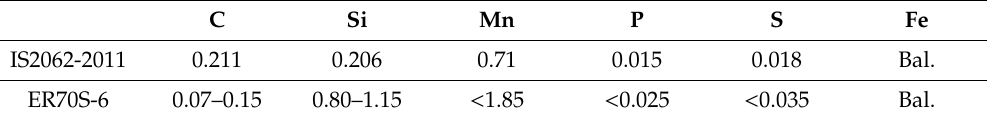
Table 1. The composition of a base metal (BM) and a filler wire.